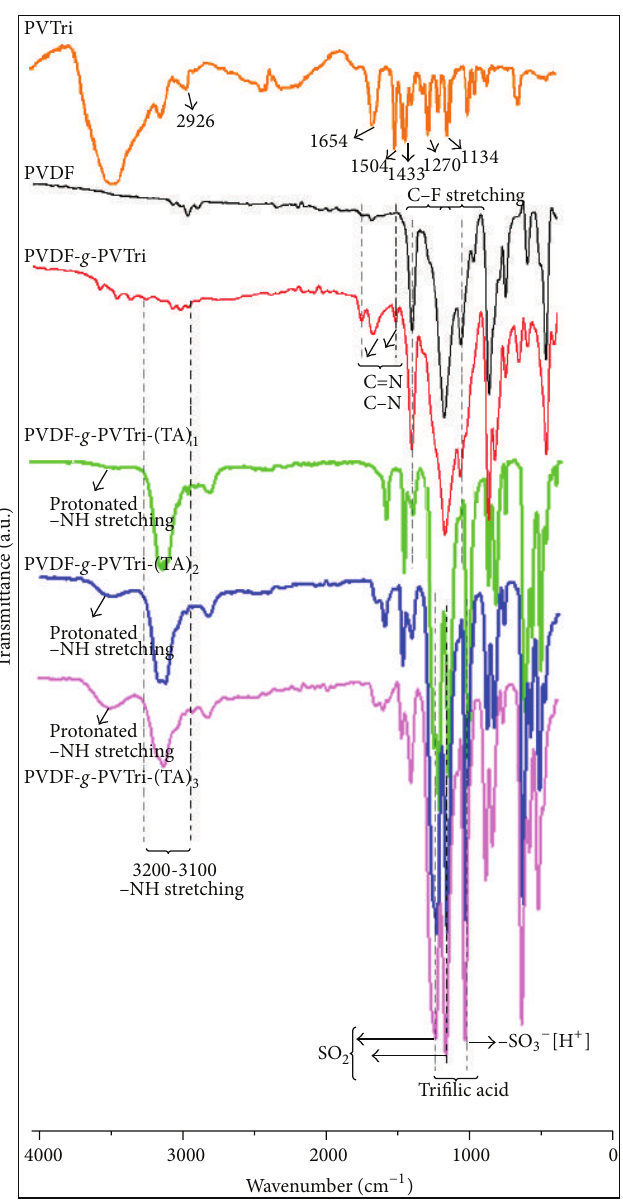
Figure 2: FTIR spectra of PVTri, PVDF, PVDF- g -PVTri, and acid-doped PVDF- g -PVTri-(TA) 𝑥 ( 𝑥 = 1.0 , 2.0 and 3.0) membranes.